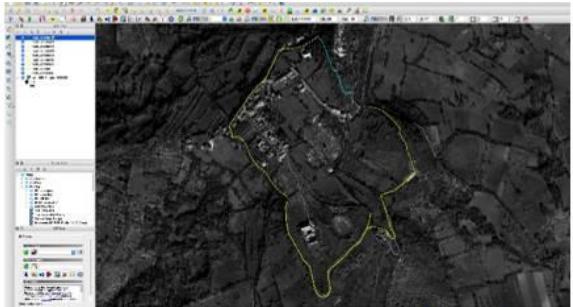
Figure 6. The megalithic certain walls, (yellow continuous line), hypnotized, (yellow dotted line) and probable tracks (cyan dotted line) superimposed to GeoEye geocoded satellite image.